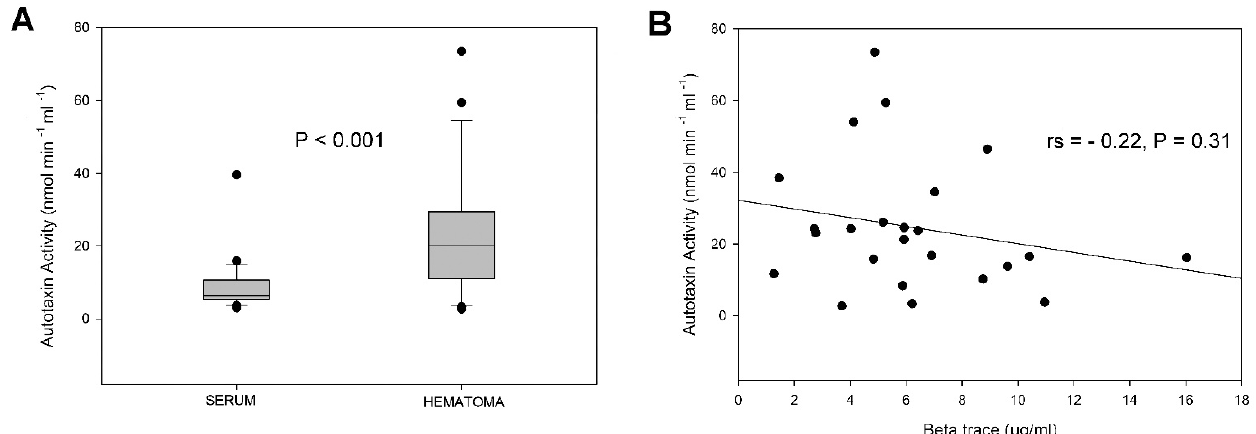
Figure 1. ( A ). Boxplot of the median (vertical lines inside boxes), 10th, 25th, 75th and 90th percentiles and outlying values (shown as dots) for autotaxin (ATX) activity in serum and hematoma fluid. There was a highly significant difference in ATX activity levels between serum and hematoma (P < 0.001) ( B ). Scatter plot of ATX activity and beta trace protein levels. The two variables did not show a significant correlation.